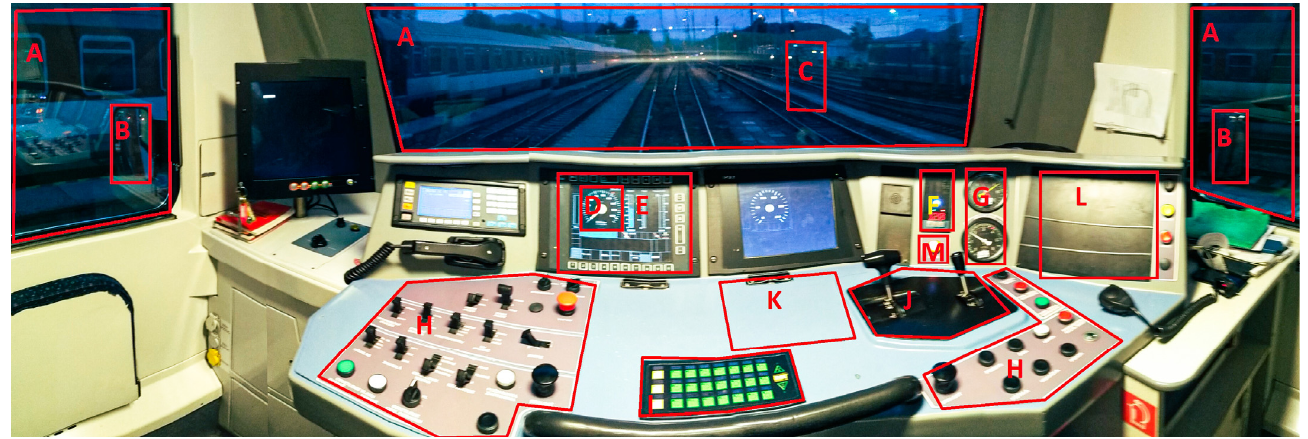
Figure 5. Area of interests (panels) identified in the EPJ 671 train cabin.